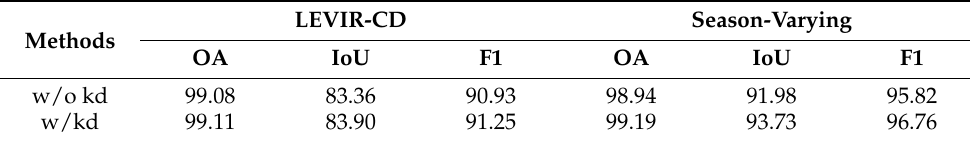
Table 7. Effects of logit distillation.